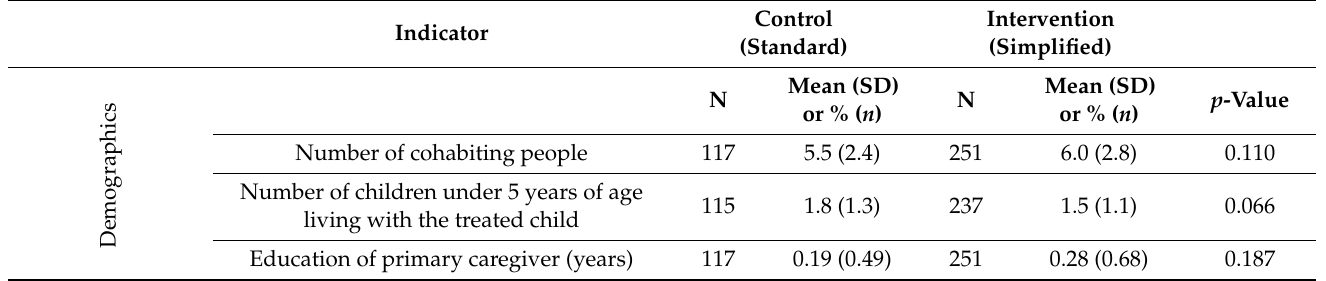
Figure 1. Flow diagram of cases. CHWs: community health workers; HMIS: health management information system; SAM: severe acute malnutrition. Table 2. Sociodemographic characteristics of cases at admission for severe acute malnutrition treat- ment, compared by study